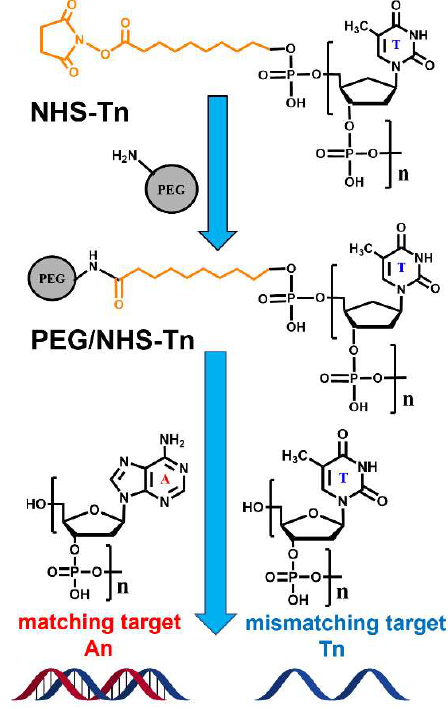
Figure 2. The structures of the NHS-Tn, An, and Tn compounds as well as a schematic illustration of the NHS-Tn immobilization in the PEG matrix (shown schematically as a gray circle) over the free (non-reacted) NH 2 groups and its subsequent reaction with the An and Tn targets.